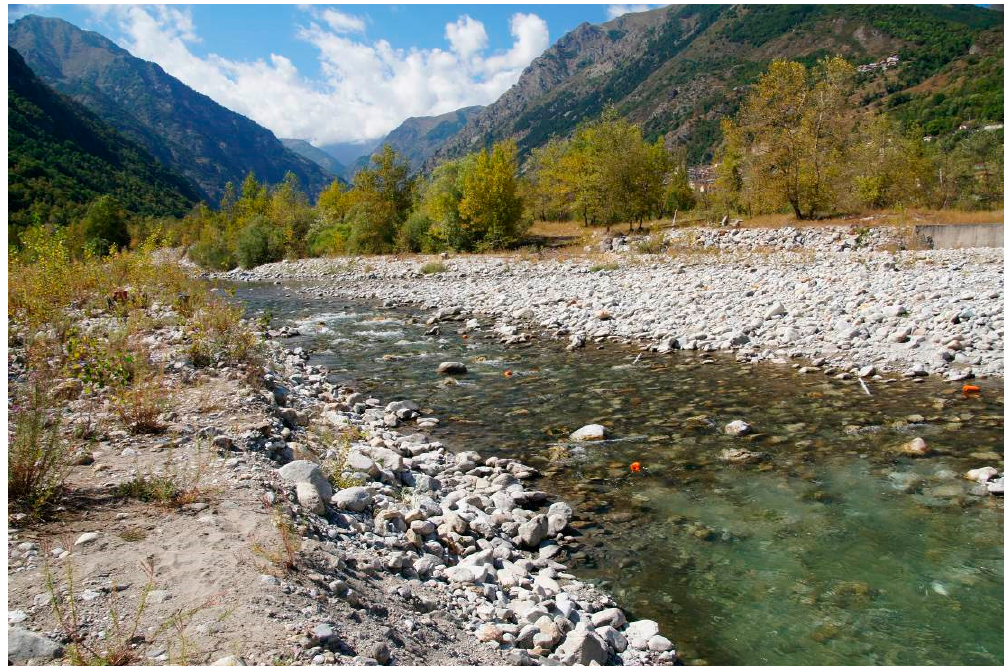
Figure 1. Three pre-exposed area electrofishing grids (PAEs) at site 1 on the Stura di Demonte River, before electrofishing, September 2014. One PAE is deployed in a ruffle (upper part of the picture), and two in glides (lower part).